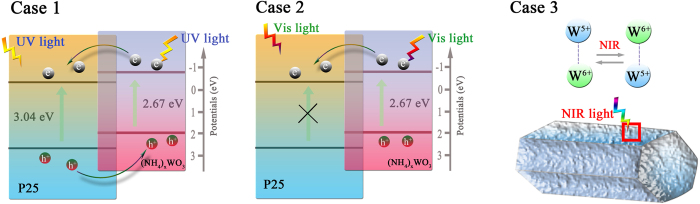
The photocatalytic mechanism of P25/(NH4)xWO3 nanocomposites.